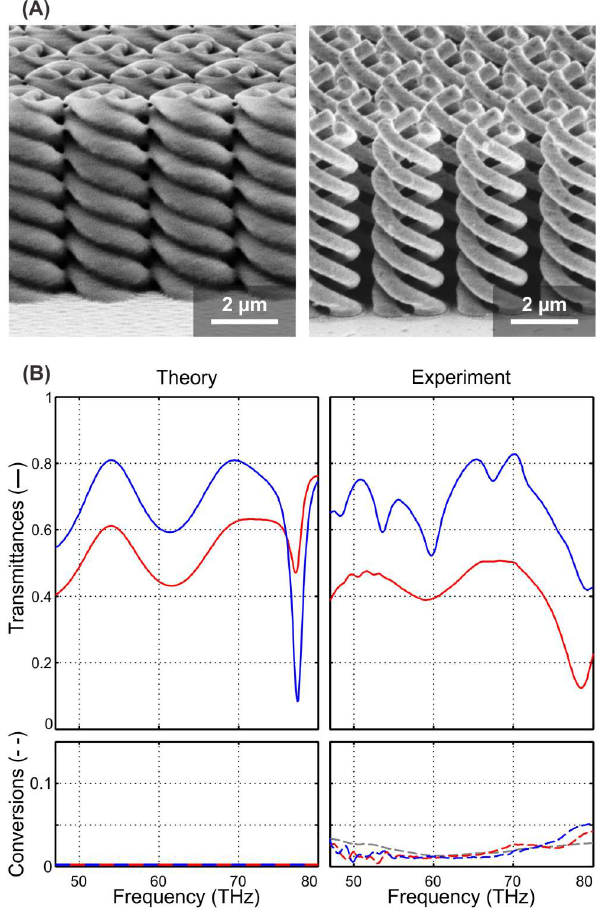
Figure 5: (A) Scanning electron micrographs of a polymer tem-plate for N = 3 helices fabricated via diffraction-unlimited STED-inspired direct laser writing on the left and the final gold structures after electrochemical gold deposition and removal of the polymer tem- plate on the right. (B) Corresponding numerical calculations and ex- perimental transmission data are shown. The top panels depict the polarization-conserving transmittances. In the bottom panels circu- lar polarization conversions are shown. It is evident that these have been reduced to a degree where they cannot be distinguished from measurement artifacts depicted by the dashed grey line (adapted with permission from [39]. Copyright 2015